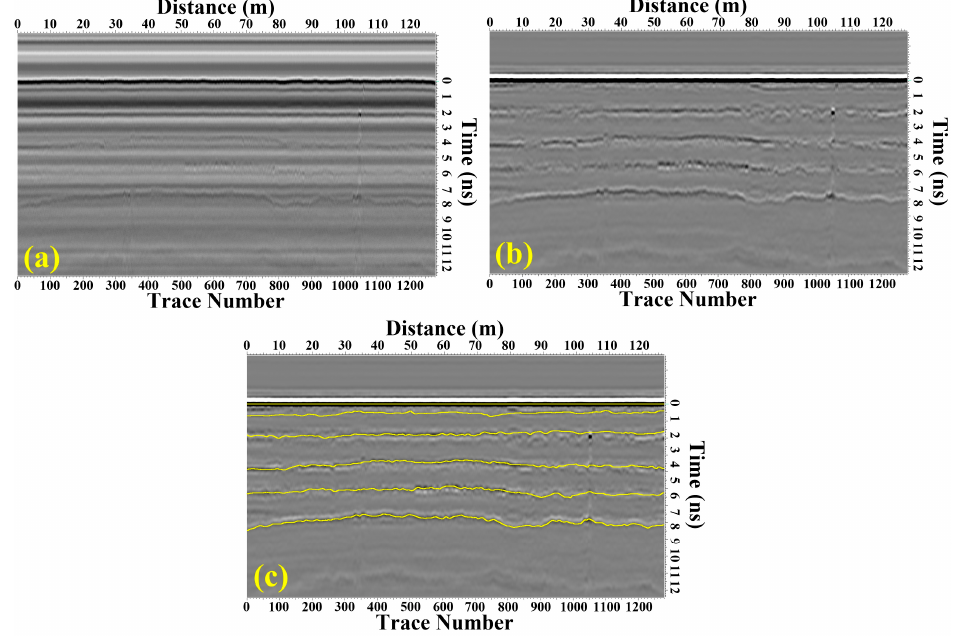
Figure 13. ( a ) The raw GPR data of STR 19; ( b ) The processed GPR data; ( c ) The underground layers of STR19.